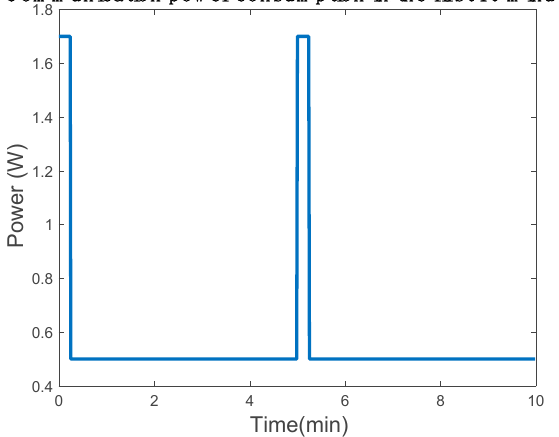
Figure 3. Communication device power consumption representation.